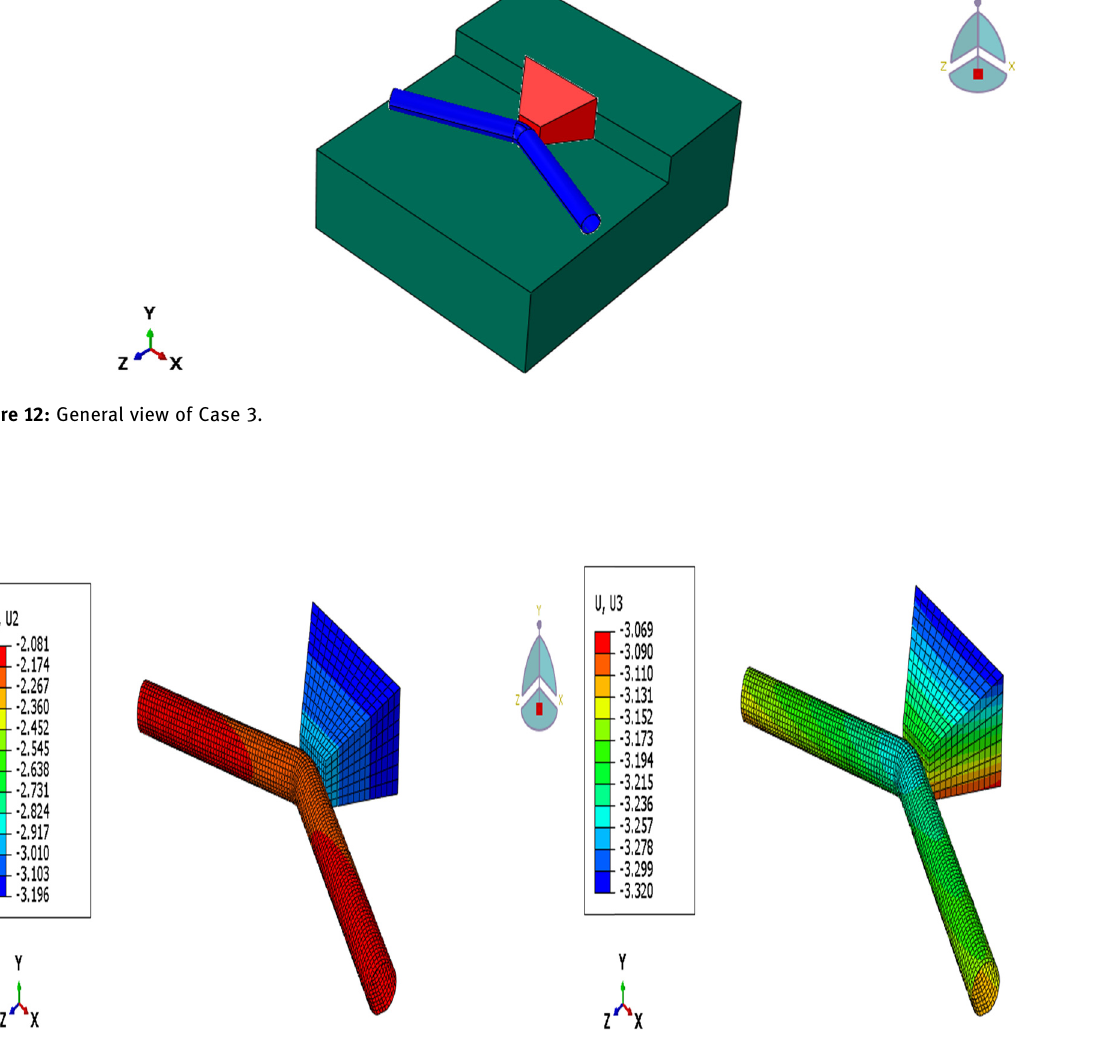
Figure 14: Horizontal displacement of thrust block ( mm )